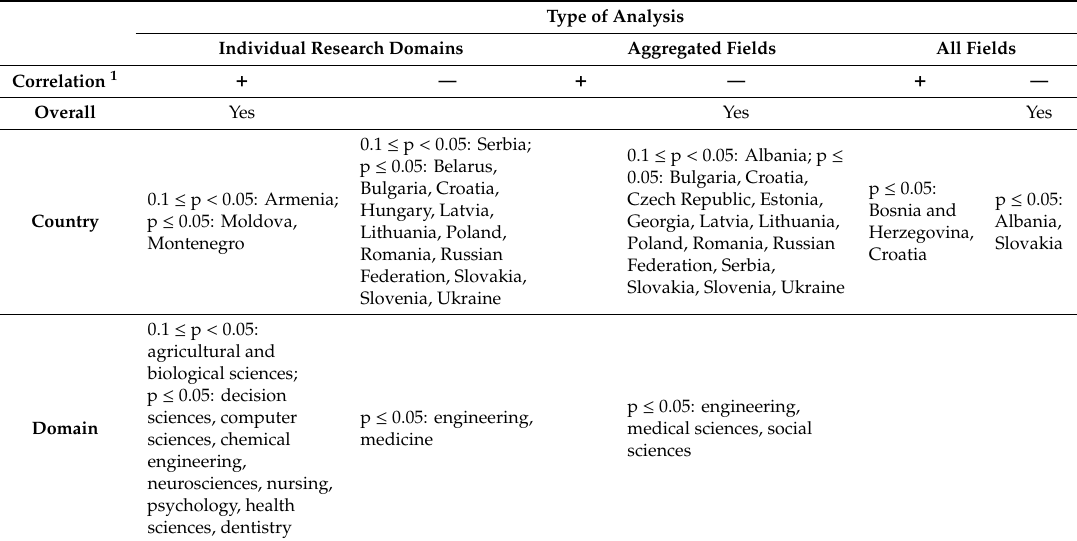
“ 1 ”,“ + ” indicates positive correlations, and “—“ negative